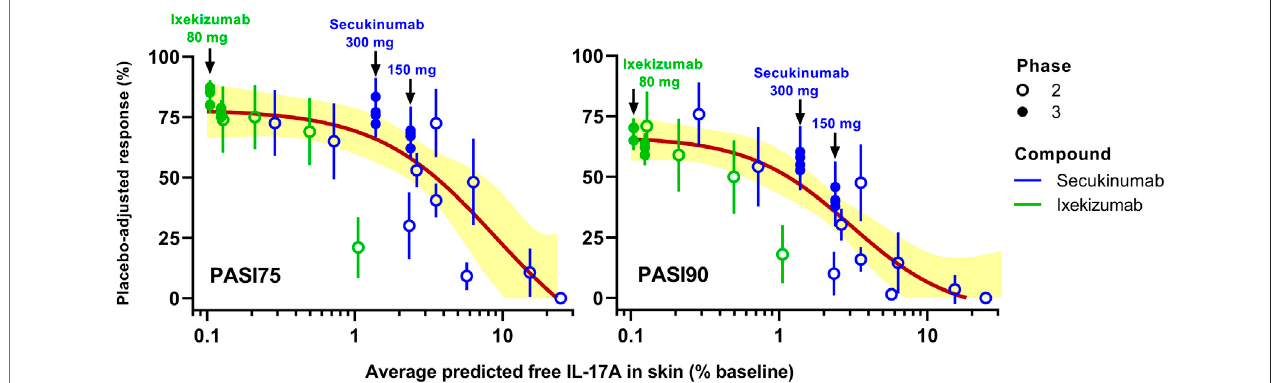
FIGURE6| Simulatedtargetengagement(TE)-basedmodel-basedmeta-analysis(MBMA)ofclinicaltrialresultsforsecukinumabandixekizumab.AverageTEwas calculated based on the concentration of free IL-17A over 12 weeks. Clinical response 12 weeks after the initial dose was used as ef fi cacy endpoint. The two approved dose regimens of secukinumab and the approved dose regimen of ixekizumab are marked with arrows on the graphs. Solid lines represent model- fi t, whereas symbols indicate observed placebo-adjusted clinical responses. Shaded bands depict the 95% CI around the TE-PASI regression curves.